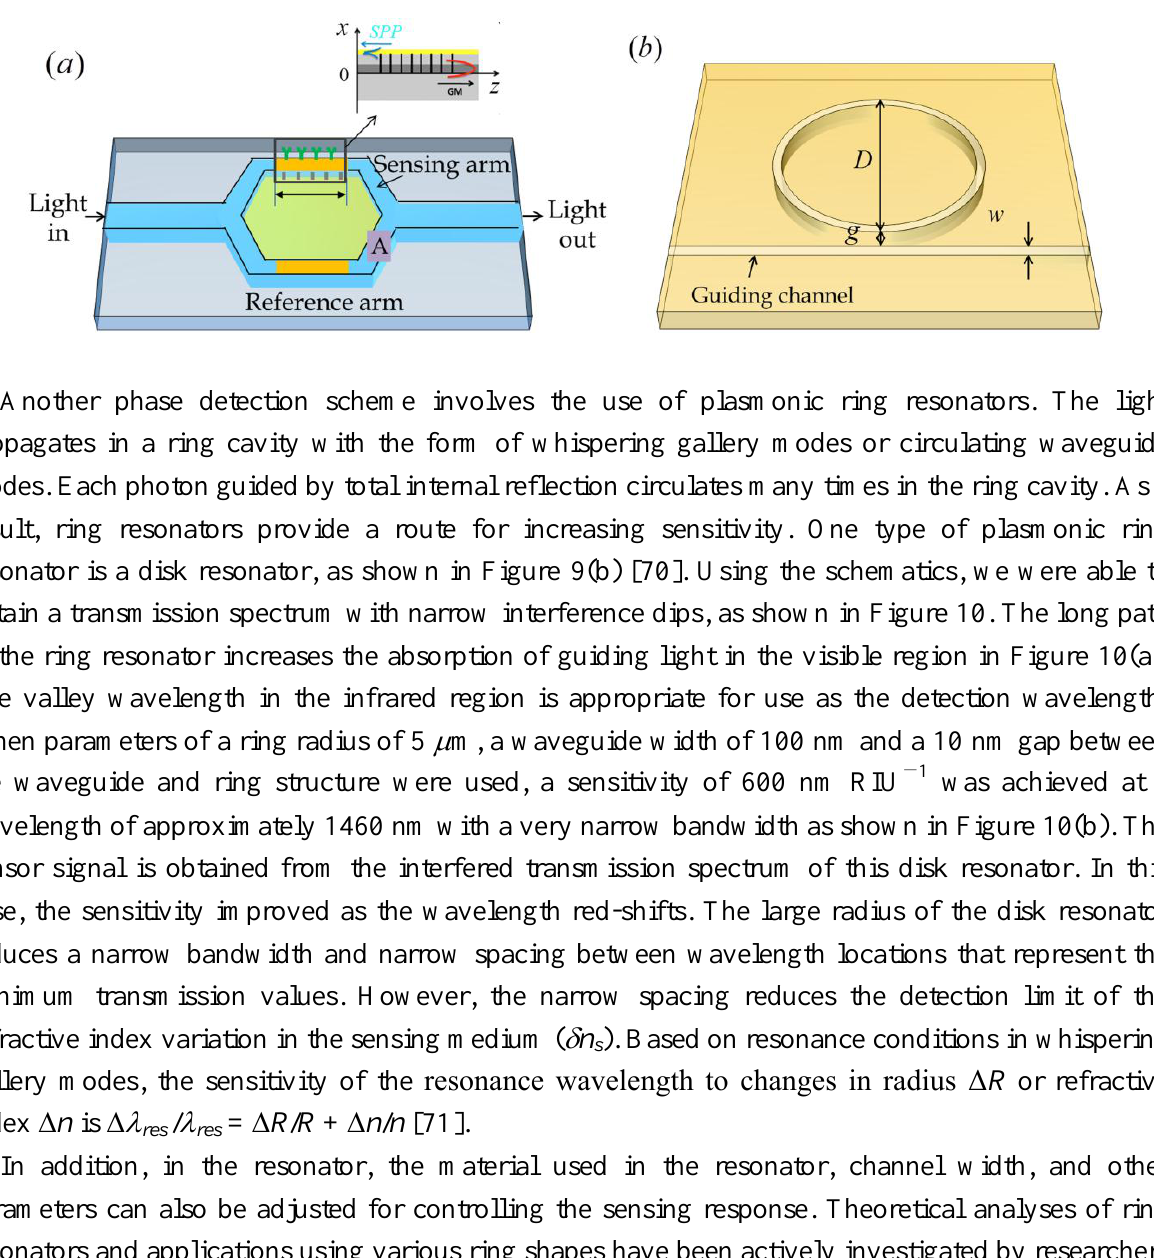
Figure 9. Schemes of SPR based sensors (a) with a Mach-Zehnder interferometer and (b) a disk